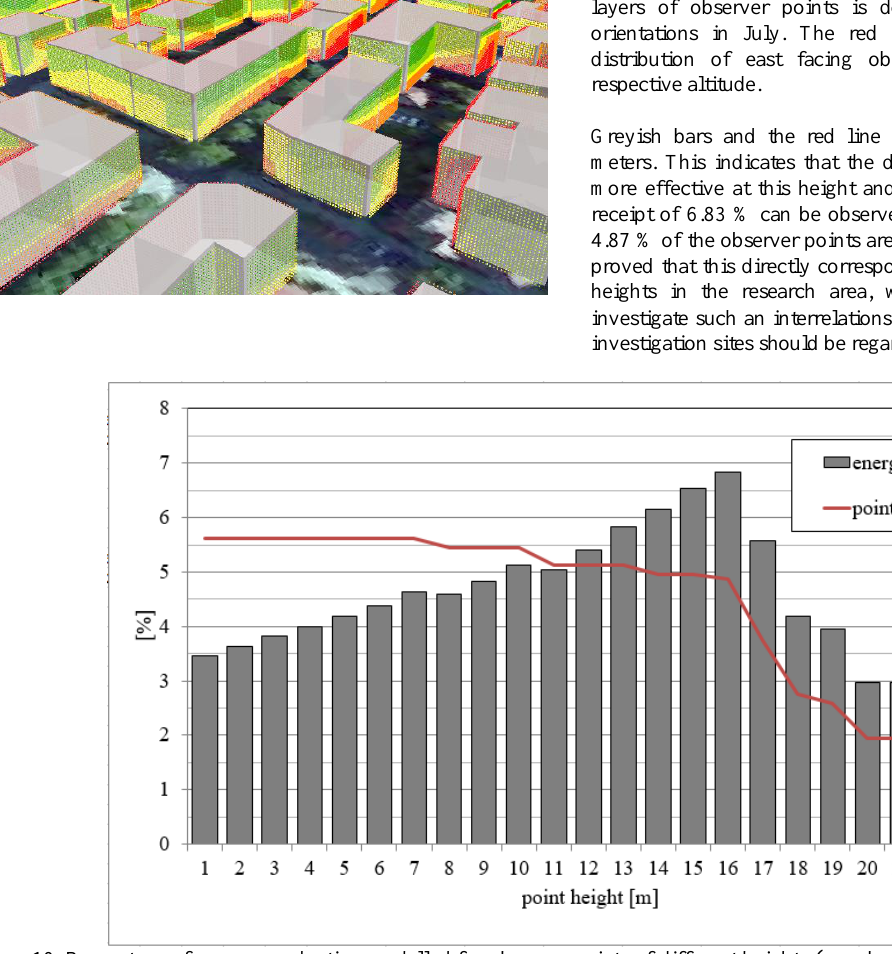
Figure 10. Percentage of energy production modelled for observer points of different heights (grey bars) on east facing walls in July. The red line indicates the percentage of points.